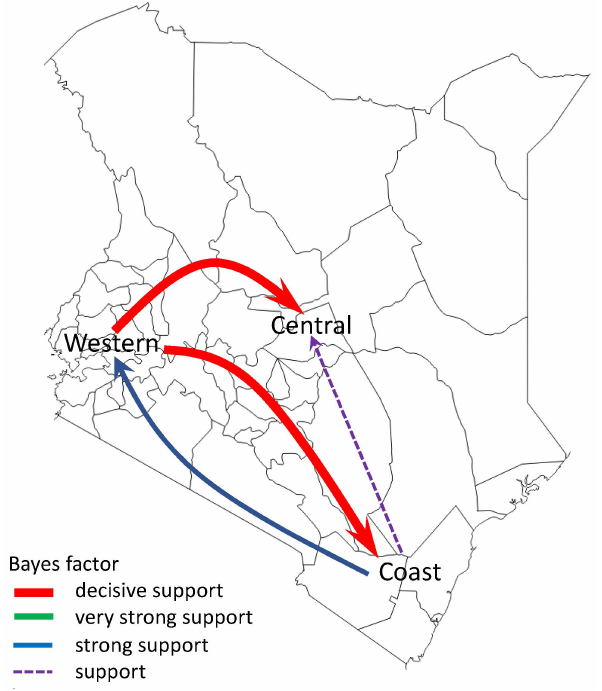
Figure 6. Networks of spread of influenza A(H1N1)pdm09 virus reconstructed using sequence data from Kenya, 2009–2018. Asymmetric pathways of spread between geographical regions of Kenya (central Kenya, western Kenya, and coastal Kenya) were inferred. Colored arrows indicate significant routes of spread from one location state to another, while line thickness represents the degree of statistical support. Red arrows are shown to indicate decisive routes of spread with Bayes factor (BF) support ≥ 1000; green lines represent very strongly supported routes with 100 ≤ BF < 1000; blue lines indicate strongly supported routes 10 ≤ BF < 100; purple dotted lines indicate supported routes with 3 ≤ BF <